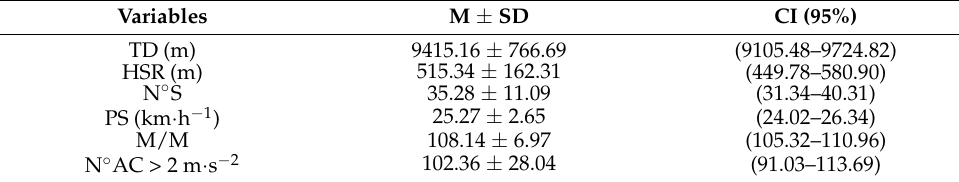
Table 2. Variables obtained from GPS in official matches ( n =